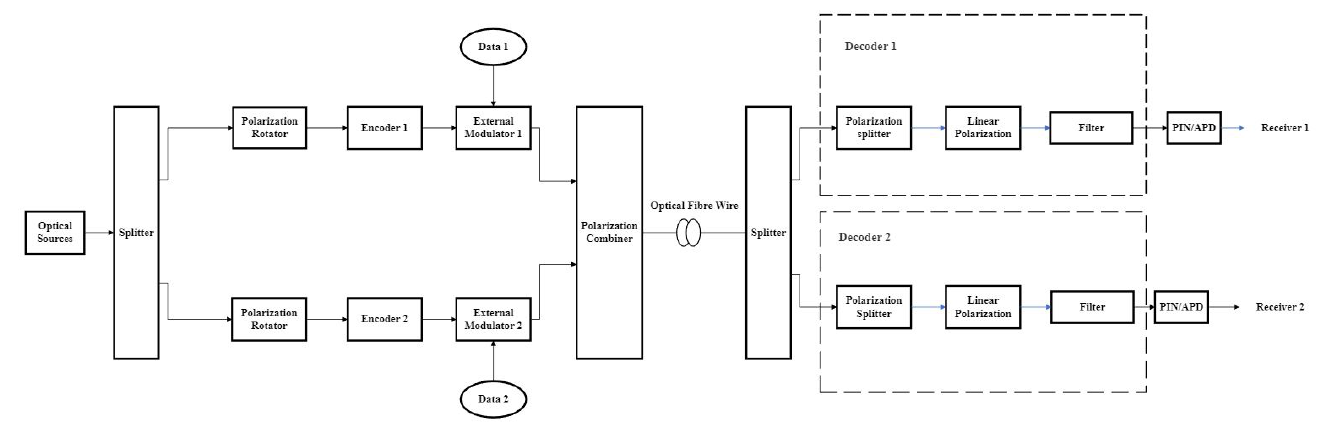
Figure 1. Polarization encoding–decoding scheme block design.